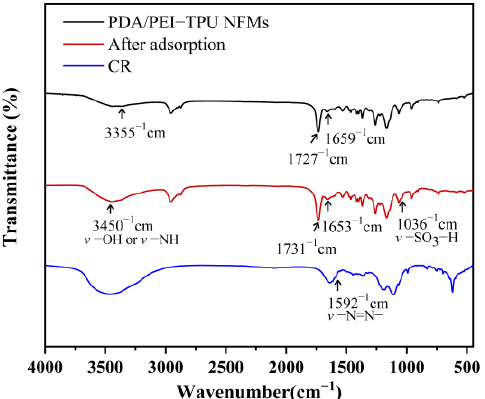
Figure 9. FTIR spectra of procured CR and PDA/PEI-TPU NFMs before and after adsorbed CR molecules.